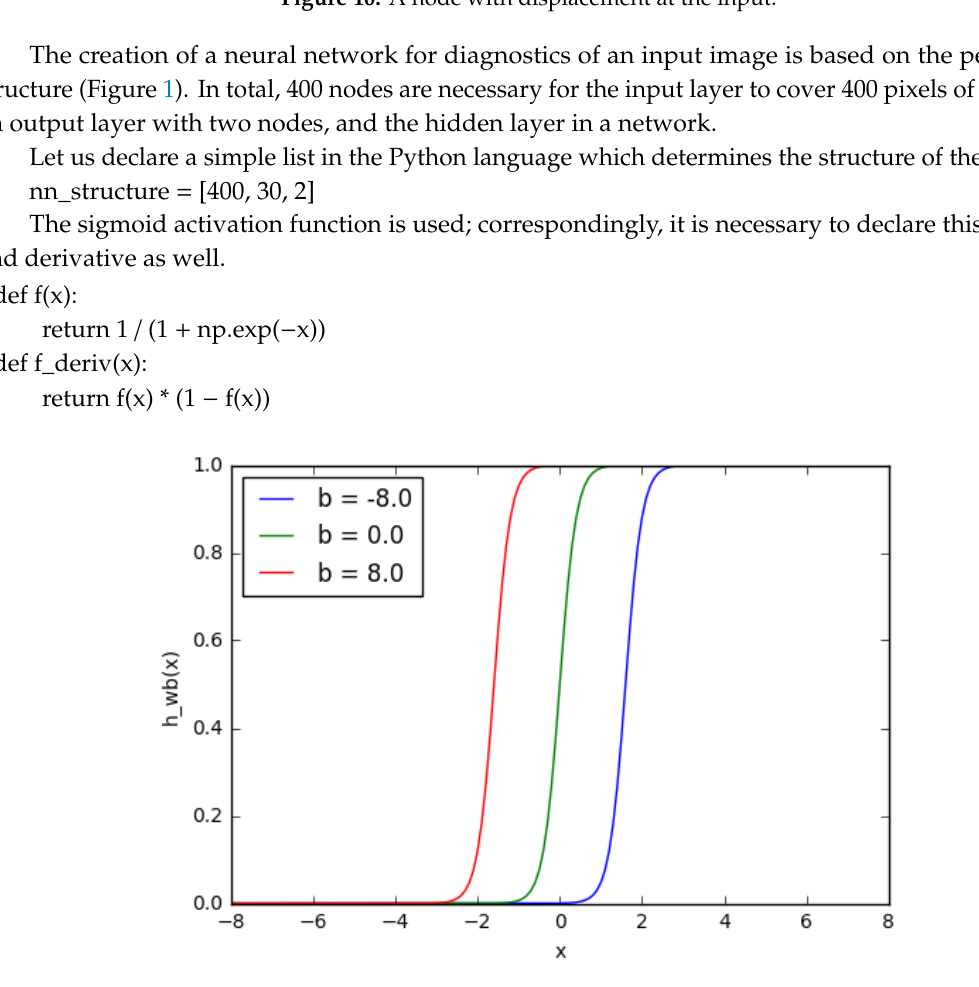
Figure 11. A sigmoid function with displacement.